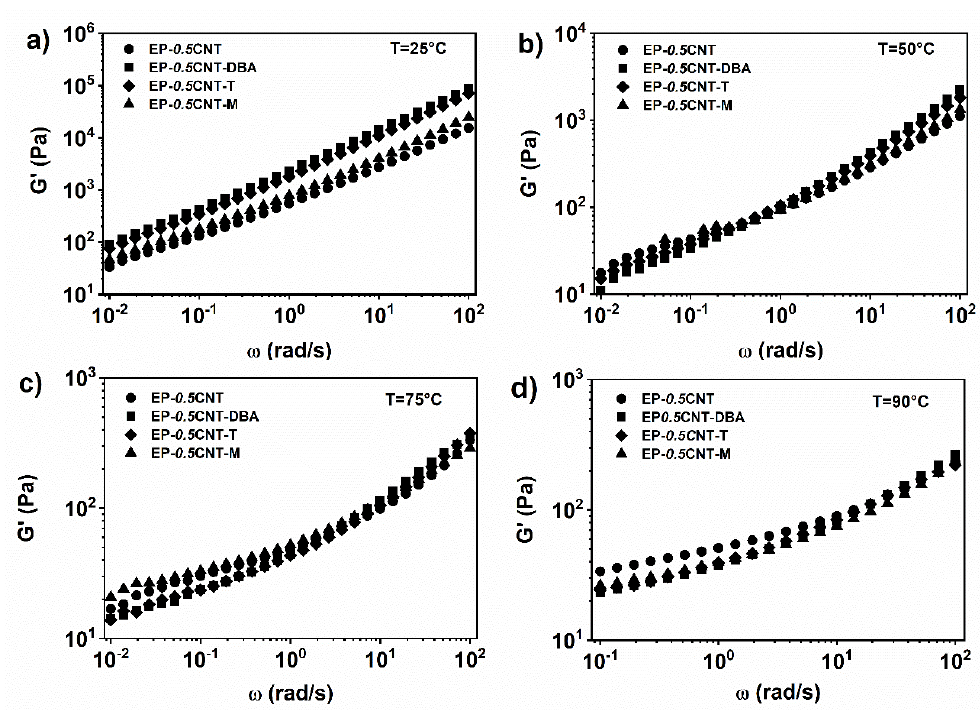
Figure 7. Storage modulus (G’) vs. frequency ( ω ) for EP ‐ 0.5 CNT, EP ‐ 0.5 CNT ‐ DBA, EP ‐ 0.5 CNT ‐ T and EP ‐ 0.5 CNT ‐ M at ( a ) T = 25 °C; ( b ) T = 50 °C; ( c ) T = 75 °C; ( d ) T = 90 °C.